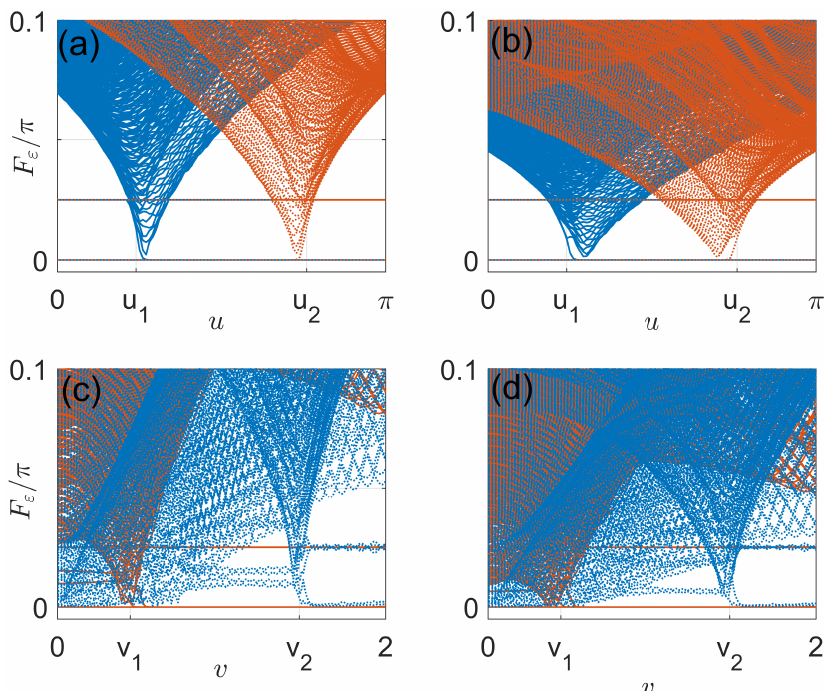
[ Eq. (31) ] in (a), (c) and U [ Eq. (32) ] in (b), 1 / 2 1 / 3